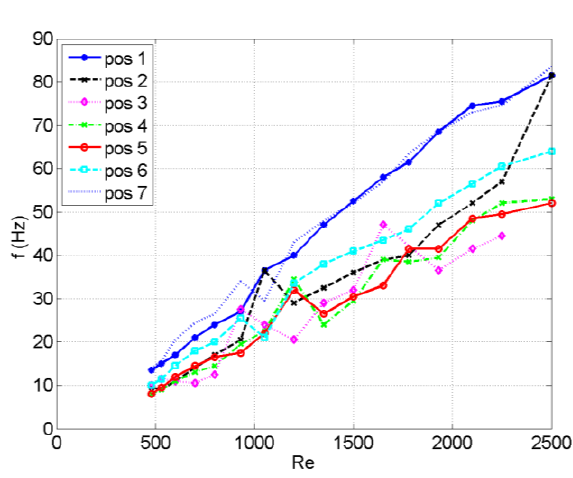
Figure 12. Relationship between the frequency and Reynolds numbers for D/d = 1